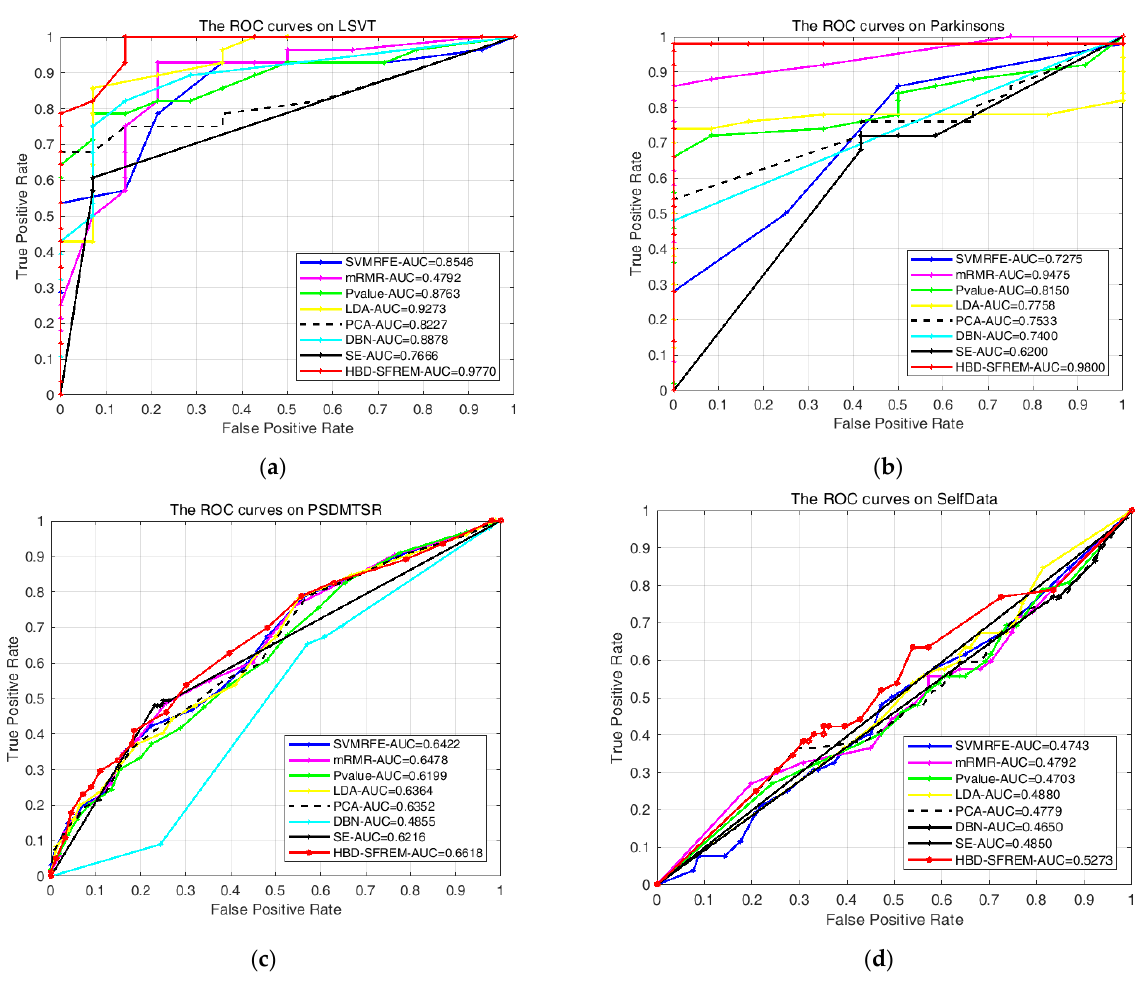
Figure 4. ( a ) Description of the ROC curves on LSVT; ( b ) description of the ROC curves on Parkinson; ( c ) description of the ROC curves on PSDMTSR; ( d ) description of the ROC curves on SelfData.